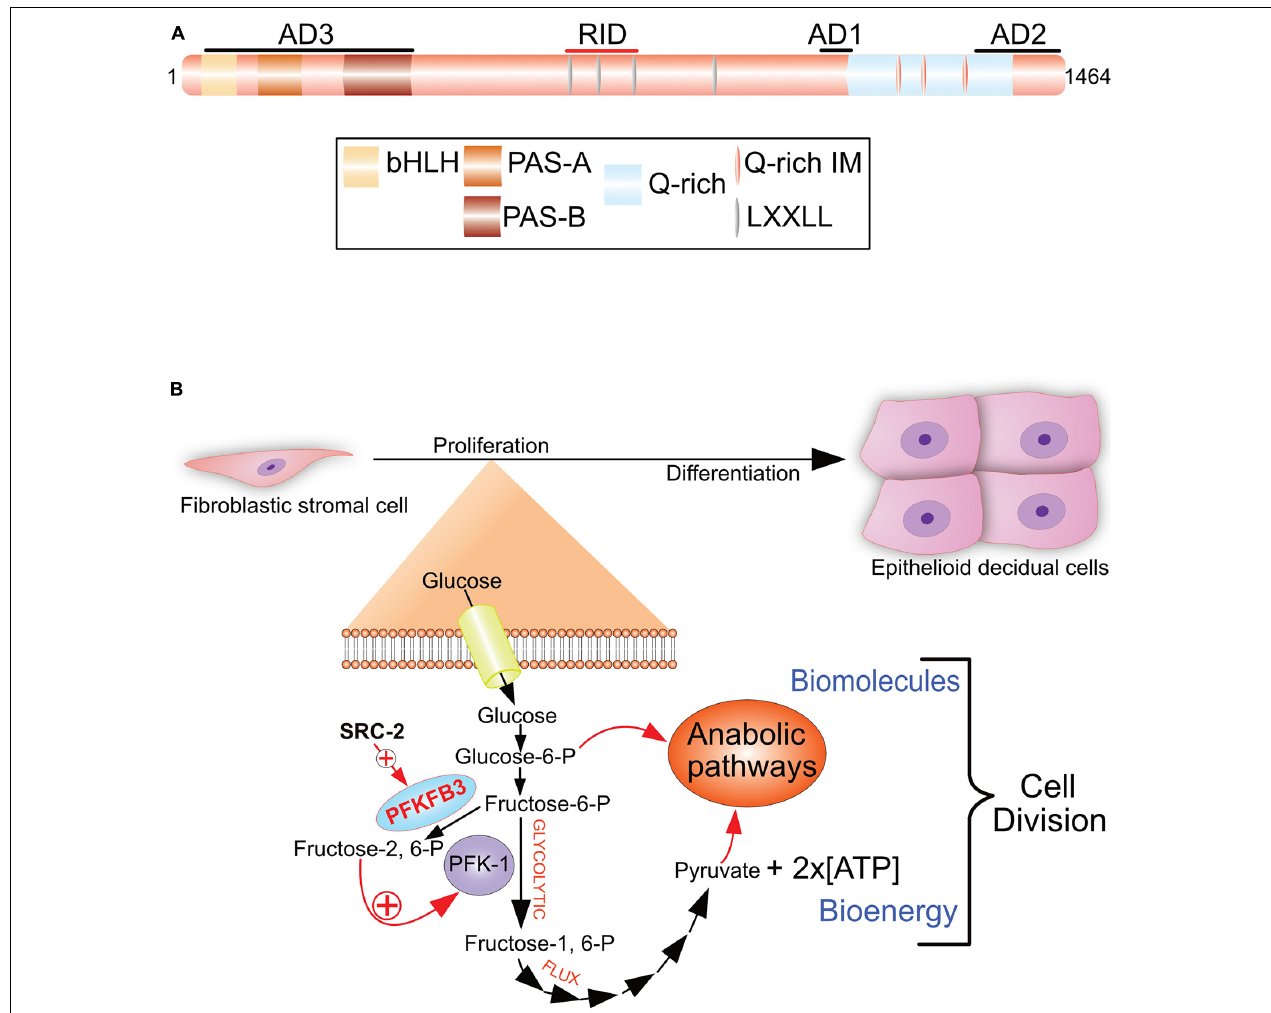
FIGURE 4 | The SRC-2 coactivator is required for progesterone-dependent acceleration of the glycolytic flux that drives endometrial stromal cell decidualization. (A) The pleiotropic properties of SRC-2 are based on its complex protein functional domain organization. Activation domains 1–3 (AD1-3), receptor interaction domain (RID), basic helix-loop-helix domain (bHLH), the Per/ARNT/Sim domains -A and -B (PAS-A and –B), leucine-X-X-leucine-leucine [X denotes any amino acid (LXXLL)], and the glutamine-rich/interaction motif (Q-rich/IM) are indicated. (B) To generate sufficient numbers of epithelioid decidual cells to support embryo implantation, stromal fibroblasts of the endometrium rapidly proliferate in response to progesterone prior to their differentiation. By markedly increasing the rate of glucose uptake and glycolysis, an endometrial stromal cell rapidly produces two daughter cells following mitosis. Glycolysis from glucose to pyruvate is referred to as the glycolytic flux. Increasing the glycolytic flux serves to rapidly provide the necessary bioenergy and biomolecules to meet the urgent demands of a proliferating endometrial stromal cell that is about to form two daughter cells. The progesterone-dependent acceleration of the glycolytic flux requires SRC-2 co-regulation of PGR-mediated induction of PFKFB3 (Kommagani et al., 2013), a potent positive regulator of the glycolytic flux. Using its kinase domain, PFKFB3 converts fructose-6-P to fructose-2, 6-P, which allosterically activates PFK-1, a pivotal checkpoint of glycolysis. Increasing the glycolytic flux results in a net gain of two ATP molecules per glucose molecule catabolized, and the generation of glycolytic intermediates (i.e., glucose-6-P and pyruvate) to furnish the required precursors for macromolecular and organelle biosynthesis by downstream anabolic pathways. 6-Phosphofructo-2-kinase/fructose-2, 6-bisphosphatase 3, phosphofructokinase-1 are abbreviated by PFKFB3 and PF-1, respectively. With permission, aspects of this figure were reproduced in modified form from Szwarc et al. (2014b).